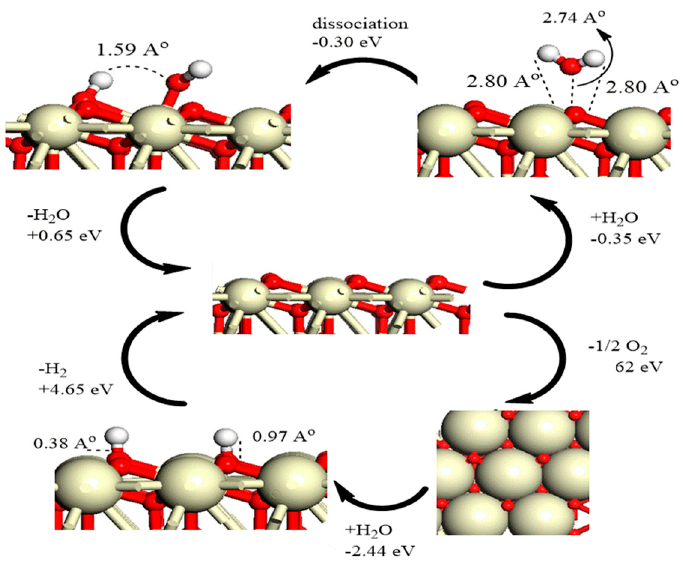
Figure 8. H 2 O and H 2 reactions on the defective and perfect ceria (111) surfaces [70].